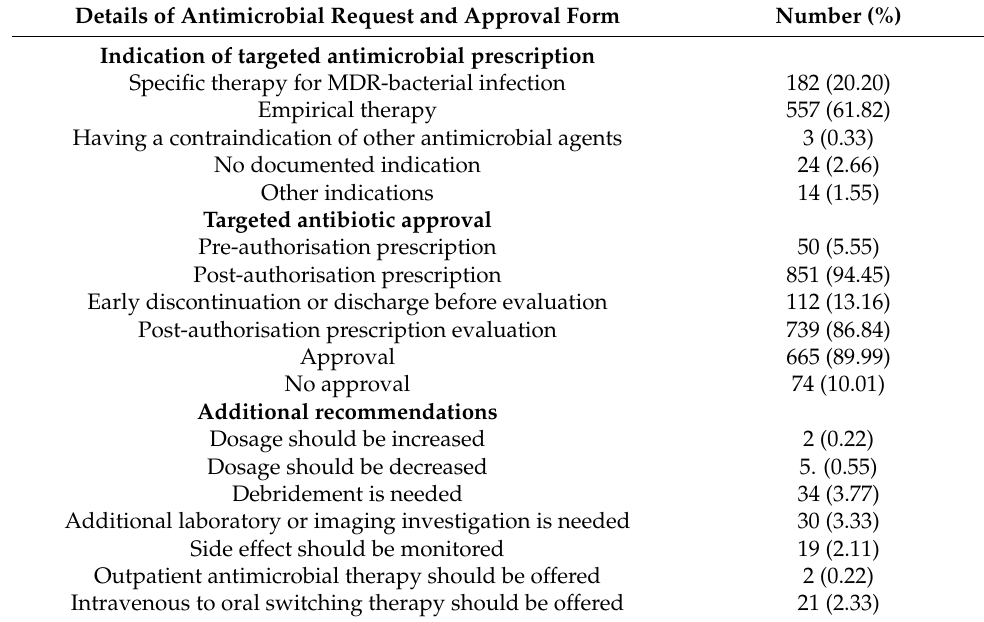
Table 5. Assessment of antimicrobial authorisation with the antimicrobial request and approval form during the post-implementation